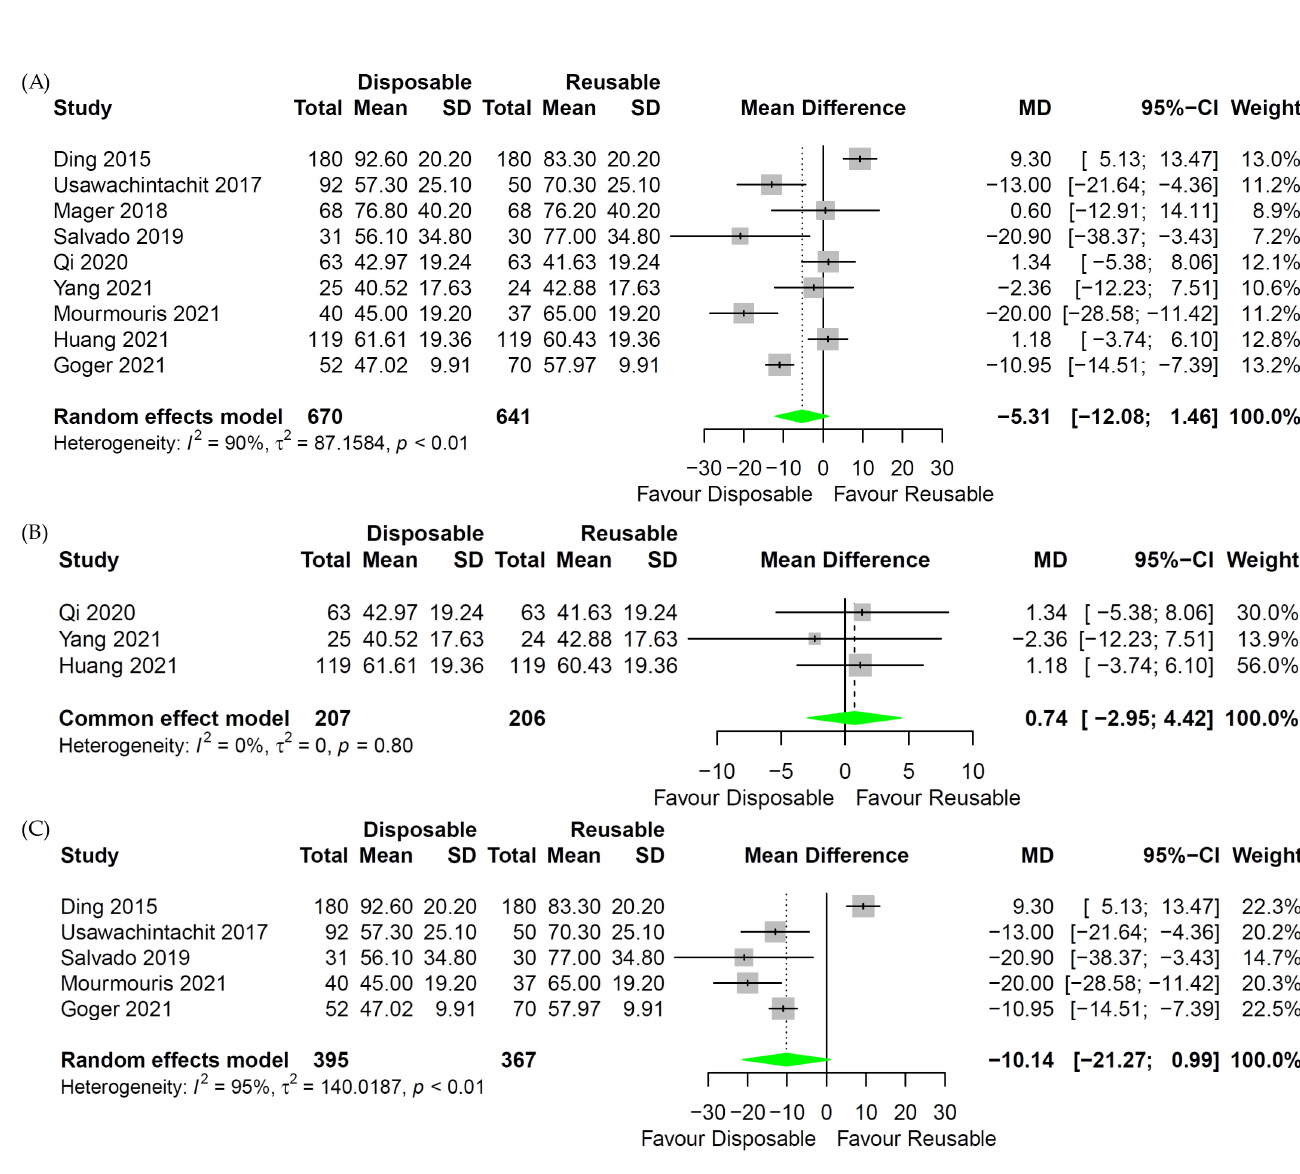
Figure 4. Forest plot for operation time between disposable and reusable flexible ureteroscopic stone surgeries (fURS). ( A ) Operation time of disposable and whole reusable fURS. ( B ) Operation time of disposable and digital reusable fURS. ( C ) Operation time of disposable and fiber-optic reusable fURS [17,19–26].